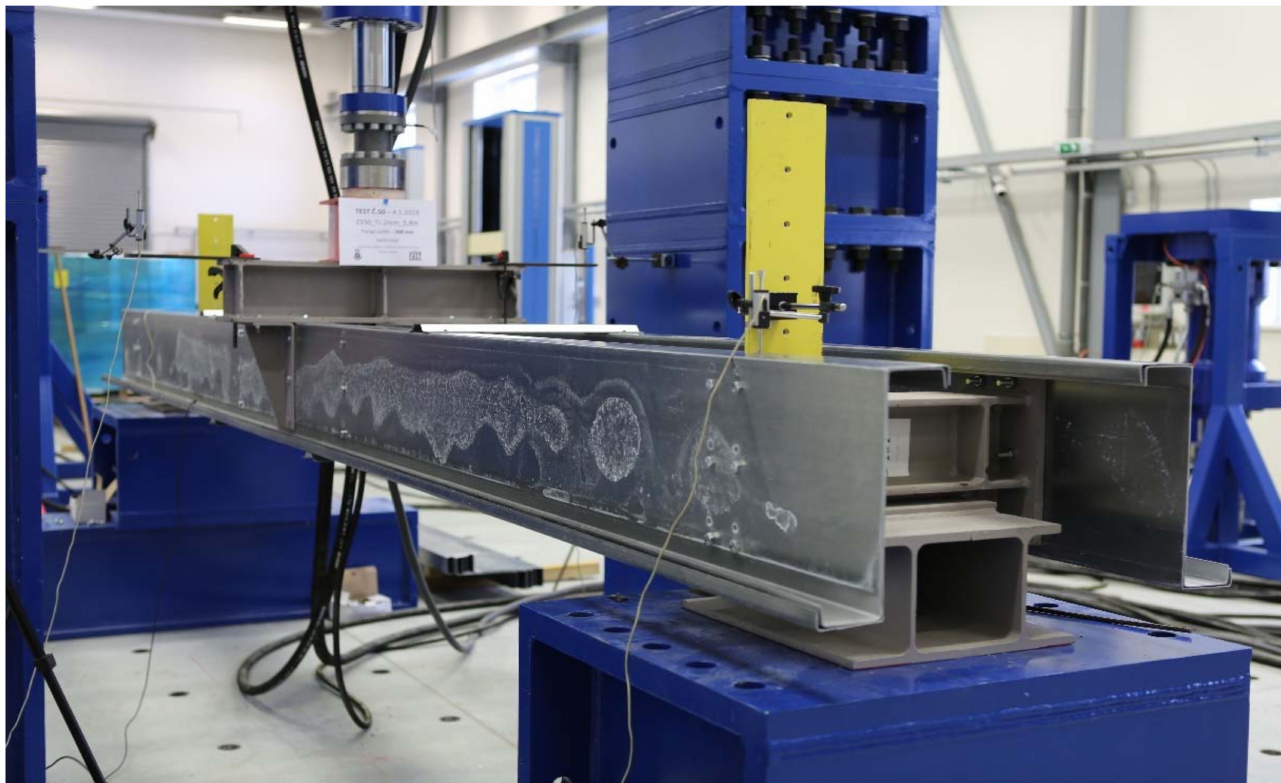
Figure 2. Experimental setup of TWCC in a hydraulic press